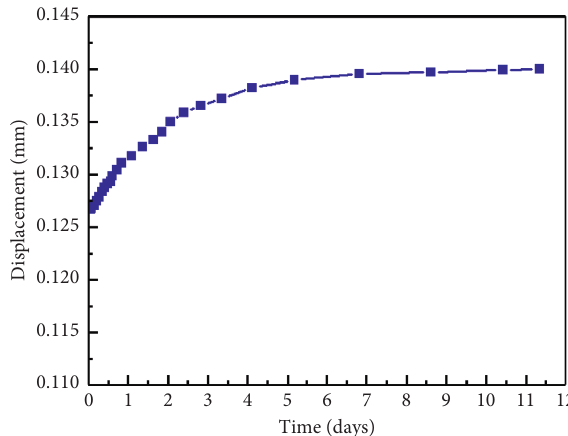
Figure 4: The radial displacement on the surface.